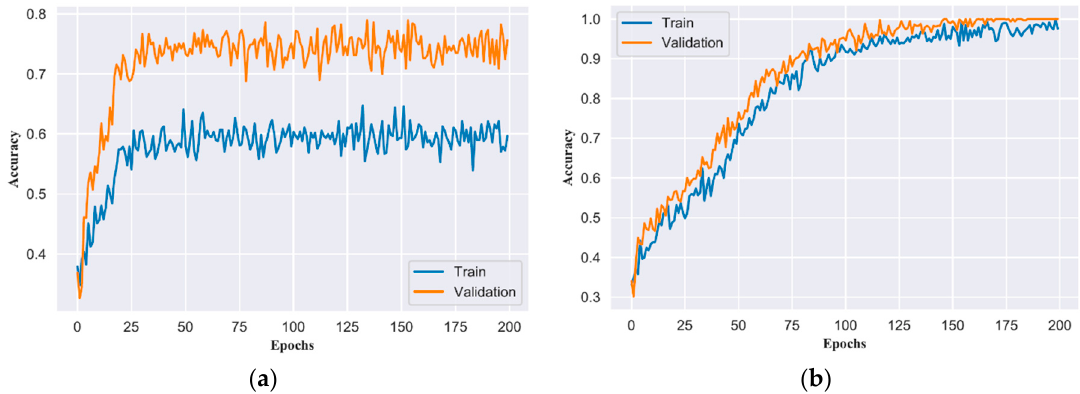
Figure 15. Result of the training and validation accuracies: ( a ) model without transfer learning; ( b ) the proposed model with transfer learning.